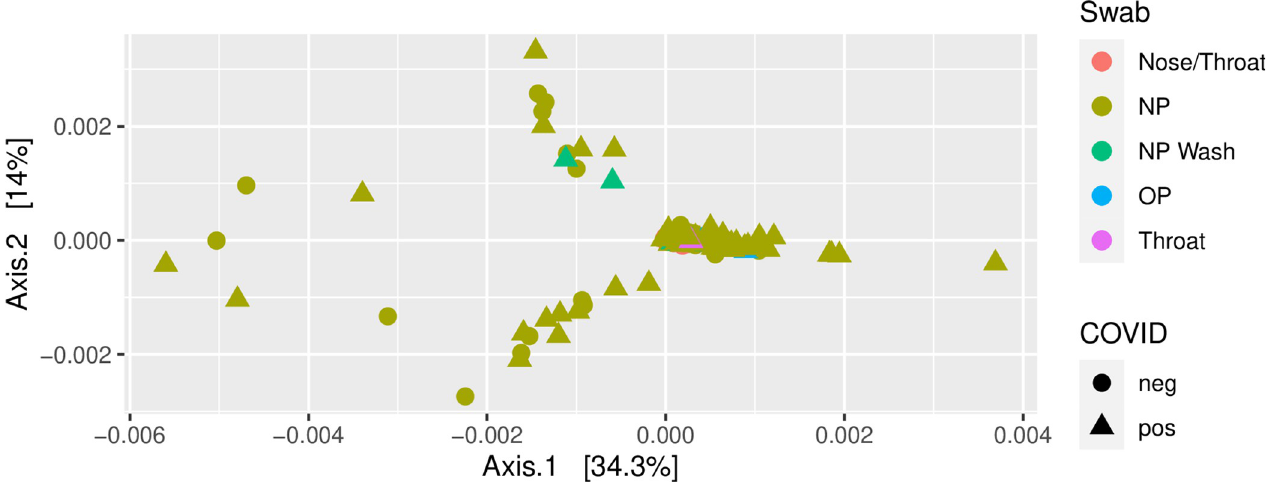
Fig 6. Principle component analysis of beta diversity distances (weighted Unifrac) between samples based on 16S rRNA amplicon sequencing data. Axes are the first two components representing the indicated percentages of the total variation explained. No clear separation between SARS-CoV-2 positive and SARS-CoV-2 negative samples is apparent, nor is there a significant distinction between sample types.